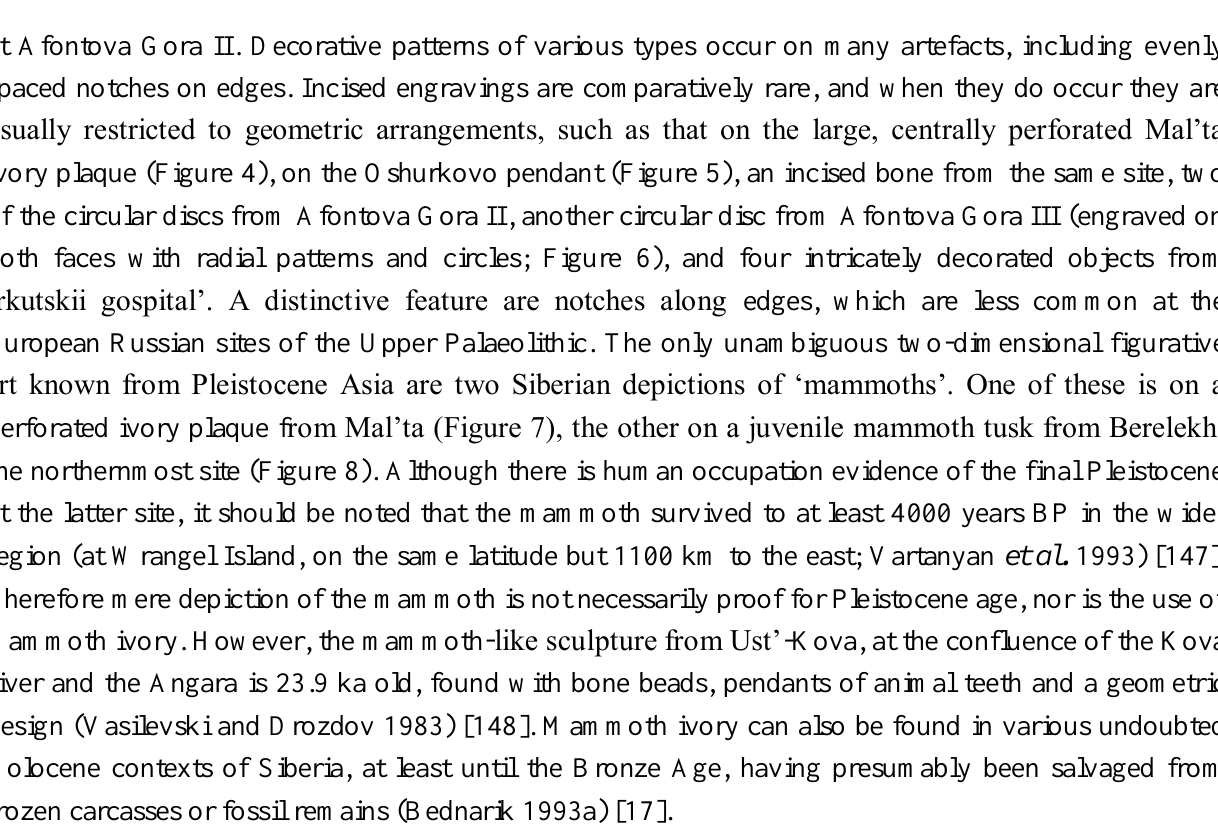
Figure 4. The centrally perforated ivory plaque from Mal’ta, engraved on both sides.